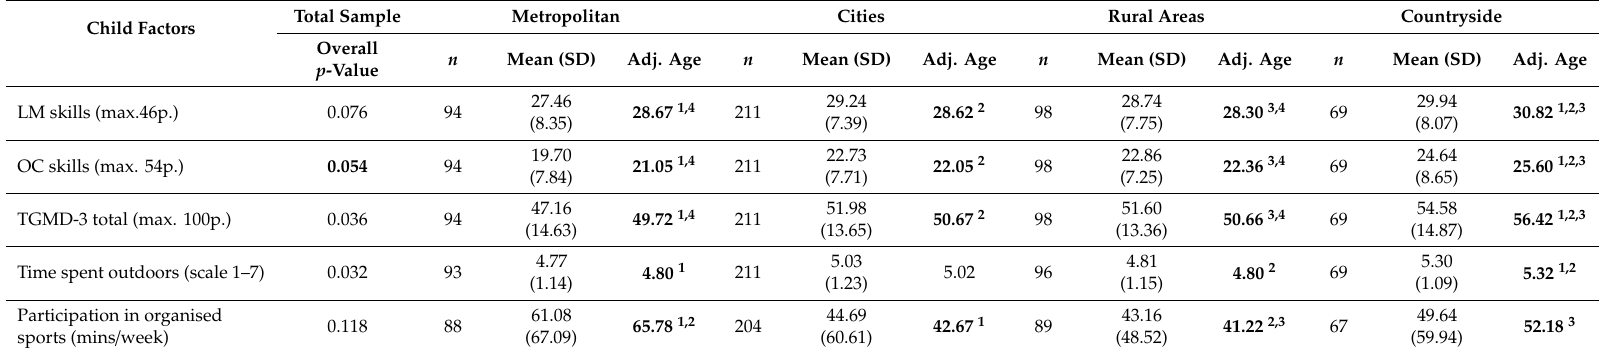
Table 5. Residential density: di ff erences in